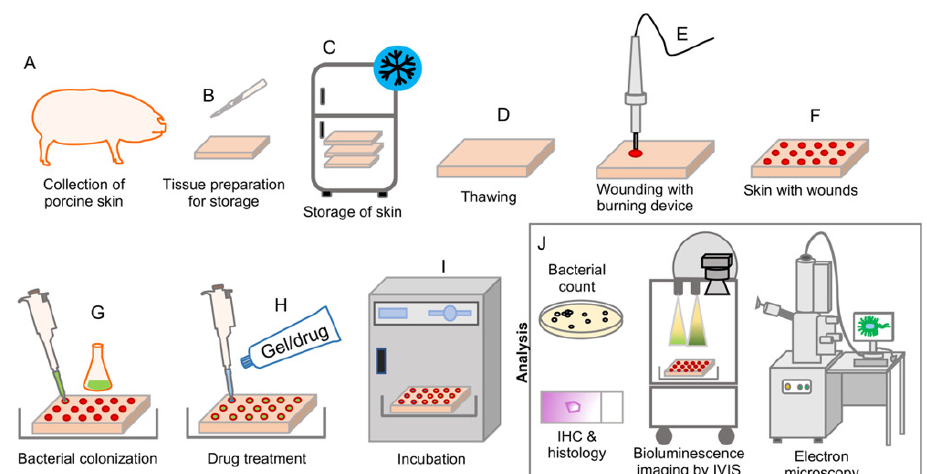
Figure 1. Graphic illustration demonstrating the experimental set-up and workflow of the ex vivo wound model. ( A ) Skin was shaved, cleaned, and surgically collected from the backs of eu- thanized Göttingen minipigs. ( B , C ) Prior to storage, the skin samples were cut into suitable sizes and packaged into aluminum foil and plastic bags, after which the packages were stored at −20 °C until use. ( D ) Skins were defrosted and thawed at room temperature for two hours and excess fat was removed using a scalpel. ( E , F ) A soldering iron had been preheated for 10 min to obtain a temperature of ~368 °C. The tool tip was placed against the skin and held with a uniform pressure for 15 s to create burn wounds. ( G ) Infection was established by adding 30 µL of 10 8 CFU/mL of S. aureus or P. aeruginosa to the wound surface . For experiments with bioluminescent measuring, bioluminescent strains were used at this step. After addition of the bacterial solution, the skin was incubated for 2 h at 37 °C to allow the infection to become established. ( H , I ) One hundred µL of antibacterial treatments were added to each wound, and the skins were placed back into the incu- bator for an additional 2 h. ( J ) After incubation with the applied treatment, samples were prepared for further analysis by several different methods. Methods used included viable bacterial count assay, histology and immunohistochemistry, and SEM. Longitudinal bioluminescence imaging using IVIS was conducted as repeated measurements during the treatment period.